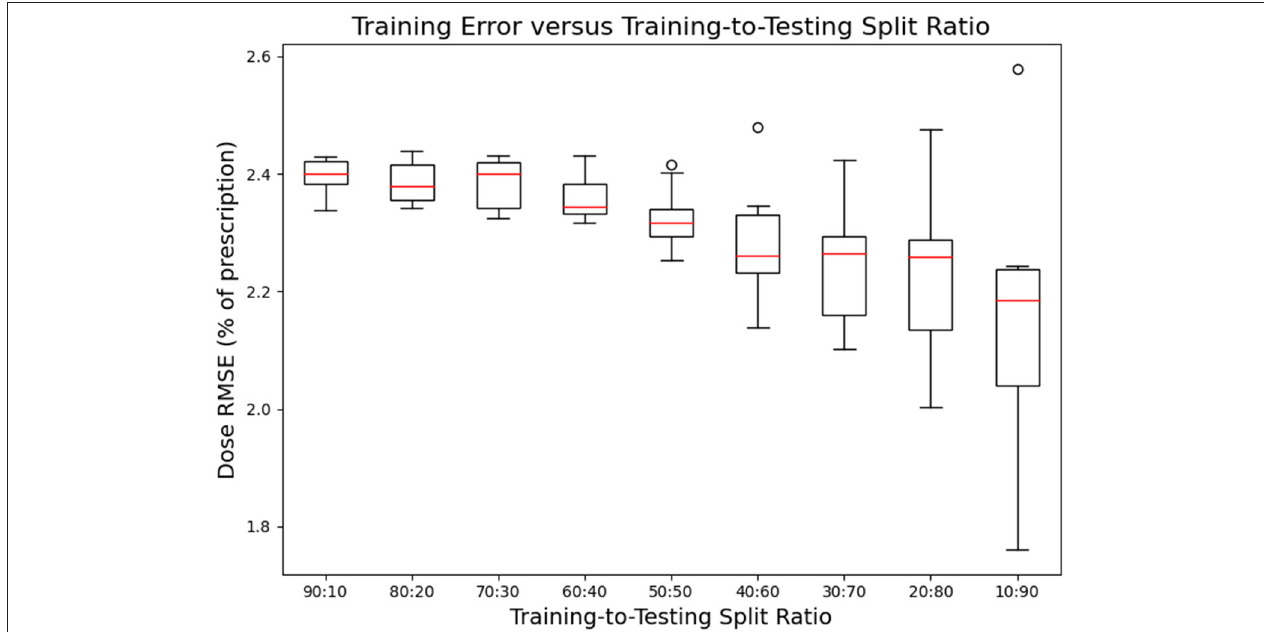
FIGURE 7 | Box-and-whisker plots representing the training set errors of the model as a function of decreasing training-to-testing set split ratios. Each box-and-whisker plot represents the aggregate errors from one split of 10-fold cross-validation.